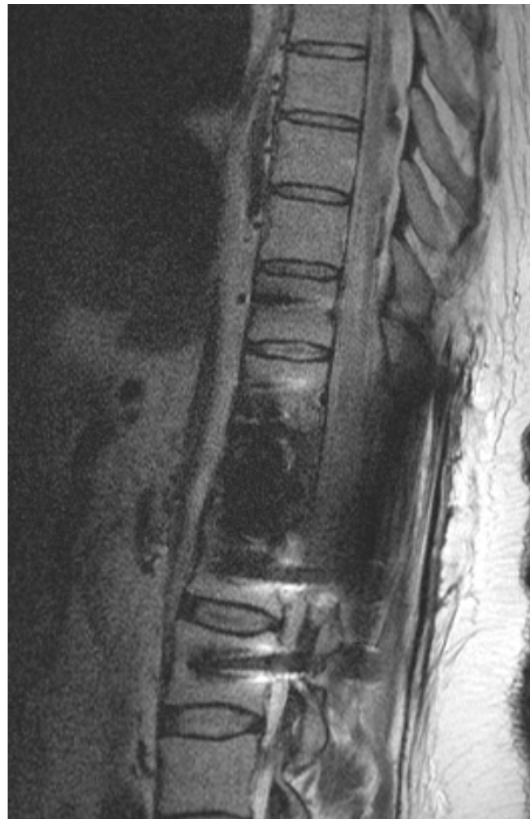
Figure 2. Illustrative example of postoperative imaging. Postoperative 1.5 T MRI after CFR-PEEK instrumentation and resection of renal cell carcinoma metastasis that was embolized preopera- tively. Patient showed paraplegia postoperatively. Because of reduced artifacts, MRI could rule